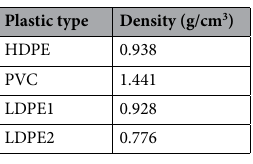
Table 1. Density determined for chipped waste plastic.